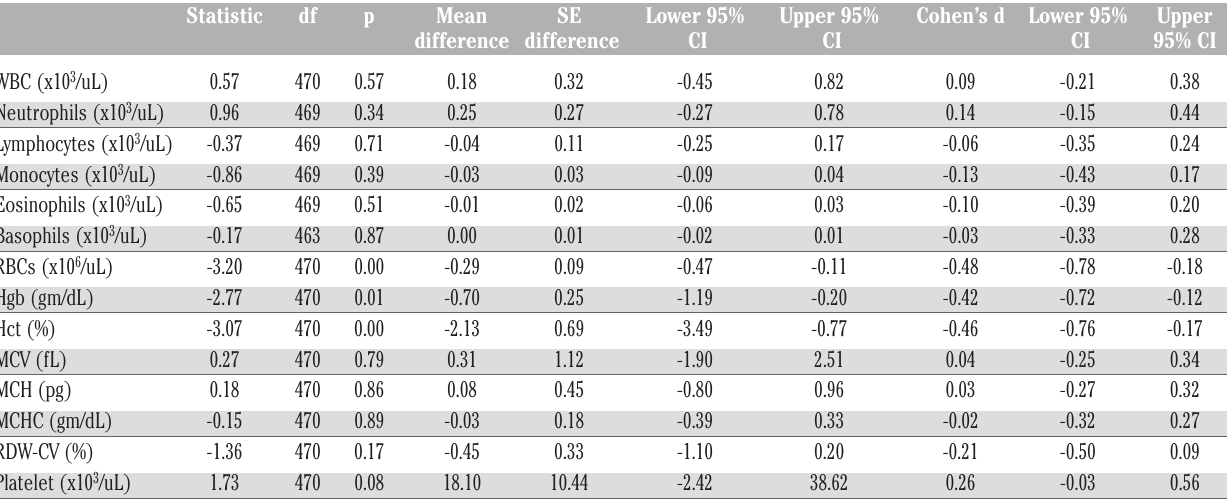
Table 3. Independent samples T-Test comparison of haematological variance between patients with positive and negative results.